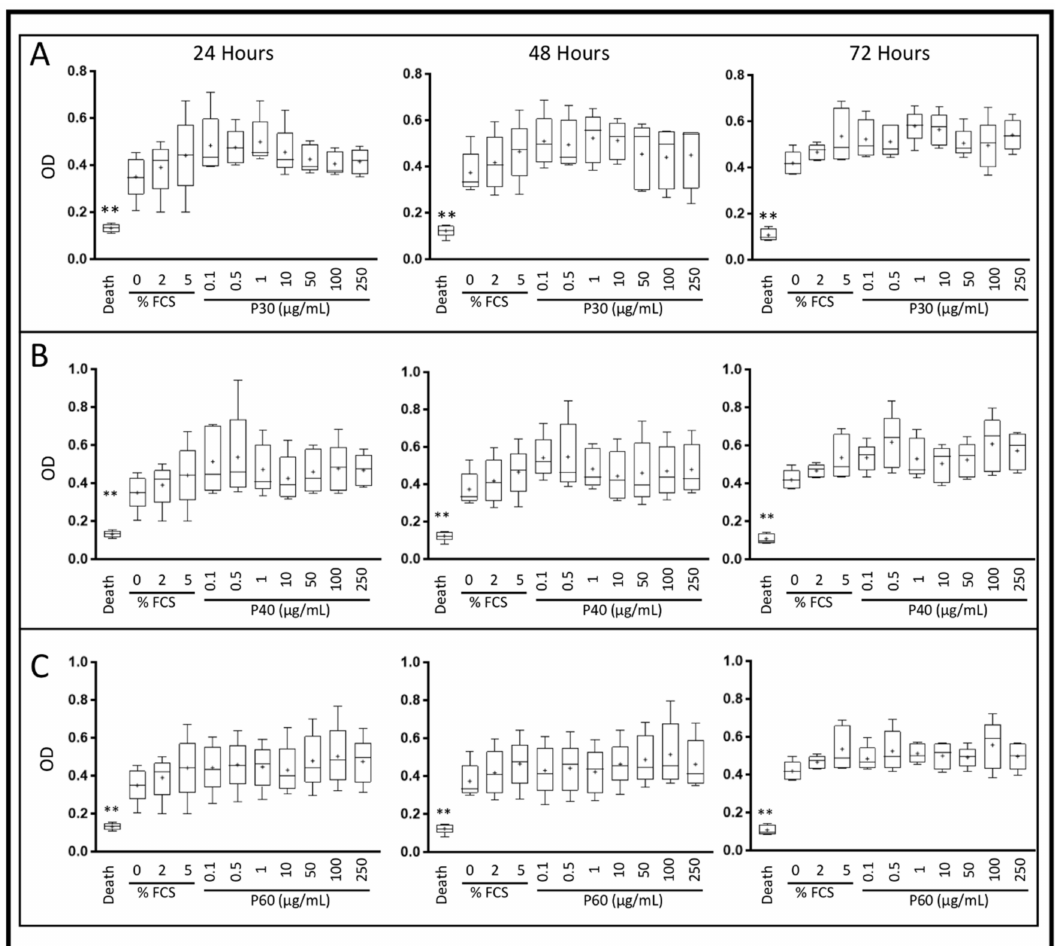
Figure 4. Effect of Promerim ® hydrolysates on the viability and proliferation of human articular chondrocytes. Human articular chondrocytes at P2 and 80% confluency were treated in the presence of 2% FCS, with 0.1, 0.5, 1, 10, 50, 100 or 250 µ g/mL Promerim ® 30 ( A ), 40 ( B ) or 60 ( C ) for 24, 48 or 72 h in hypoxia. Controls with 0%, 2% and 5% FCS, and a positive control of 100% cell death (Triton-induced death) were performed. Formazan levels, which are correlated with viability and proliferation, were measured in the media after 24, 48 or 72 h of treatment. Results are summarized in box plots ( n = 5) showing the mean (cross) and the median (line) of optical density (OD). Statistical analyses were performed using the Mann–Whitney test (** p < 0.01) compared with the 2% FCS